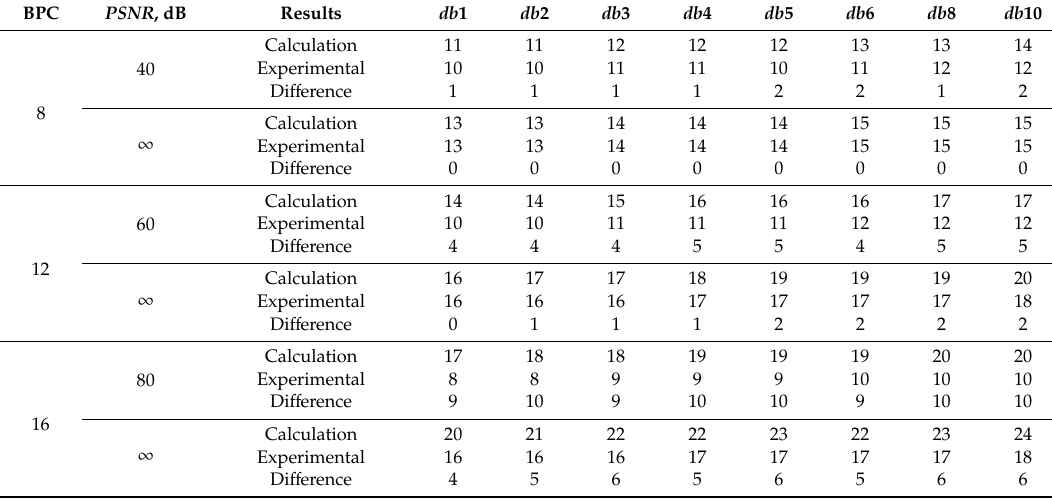
Table 31. Minimum values of r , at which the result of 3D tomographic images DWT by Daubechies wavelets reaches high and maximum